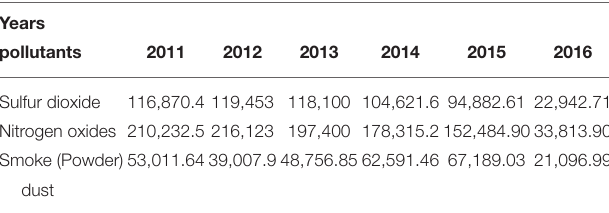
TABLE 1 | Major pollutant emissions of Z City from 2011 to 2016 (Unit: